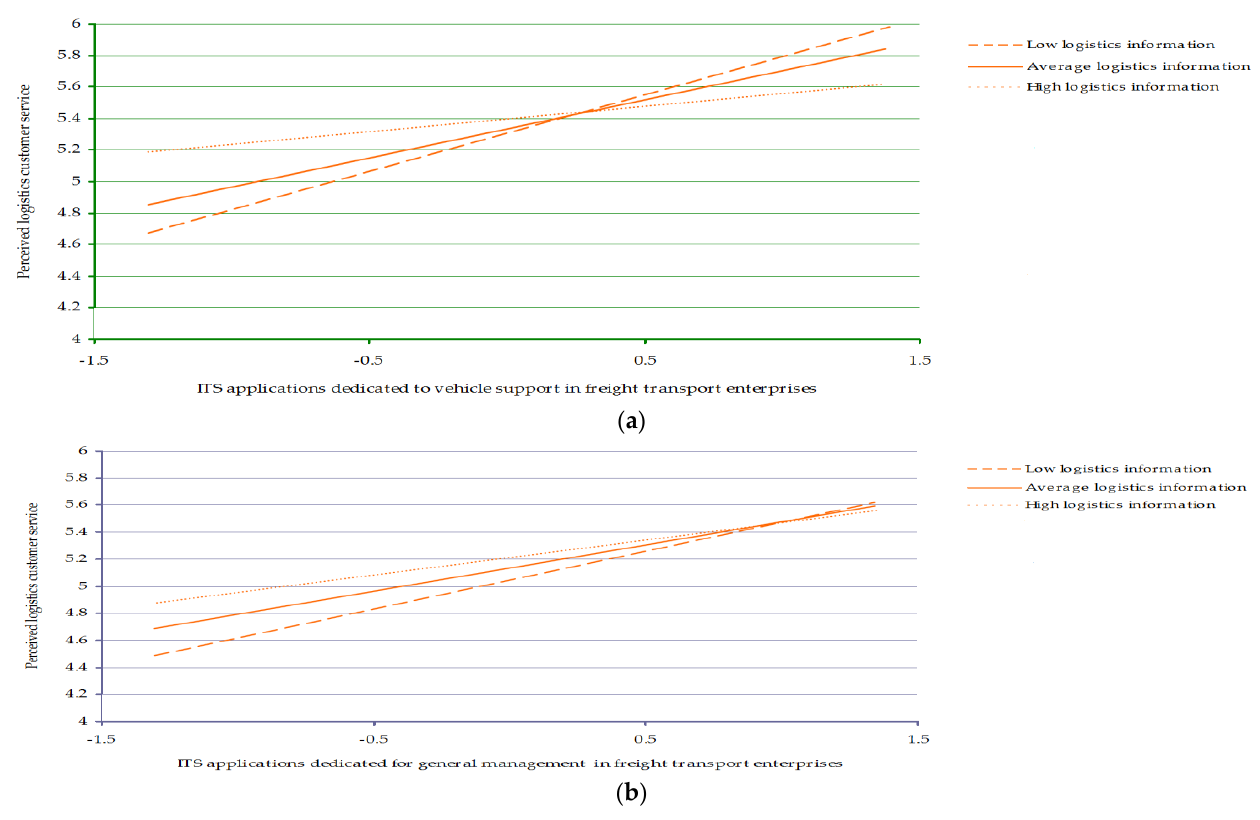
Figure 3. Moderating effect of logistics information for: ( a ) ITS applications dedicated to vehicle support in road freight transport enterprises, ( b ) ITS applications dedicated to general management in road freight transport enterprises.